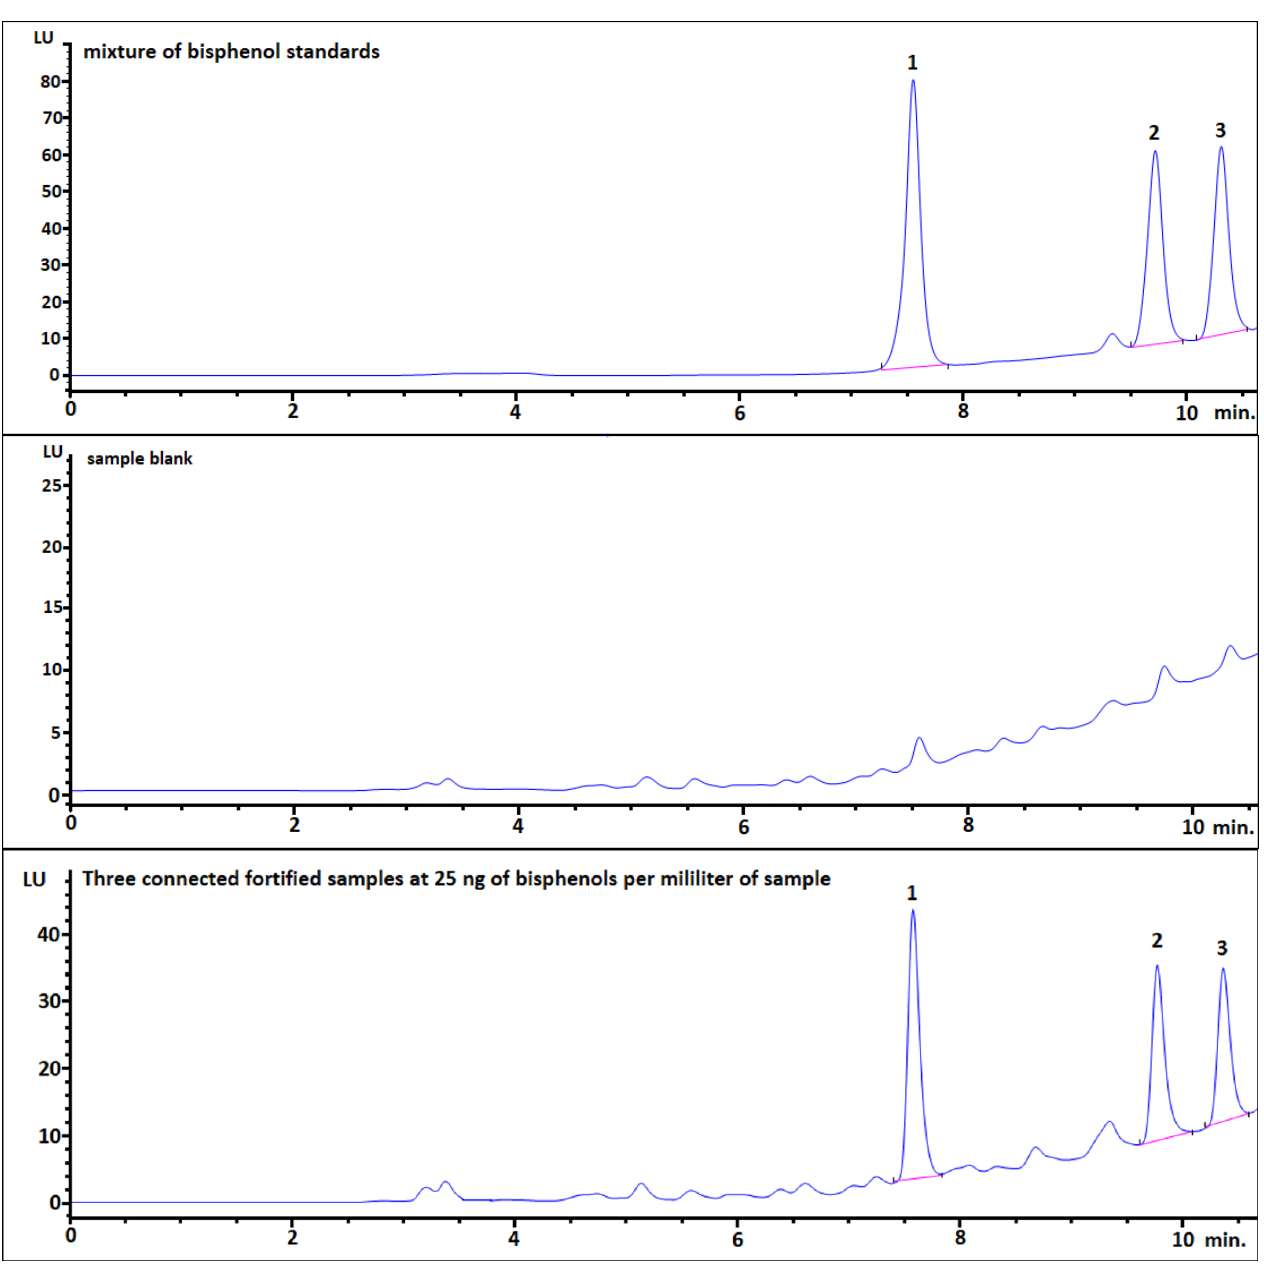
Figure 2. Comparison of following chromatograms: mixture of bisphenol standards ( top ); chromatogram of blank human urine matrix sample ( middle ); three samples of blank human urine matrix samples which were spiked with mixture of bisphenol standards at the same level (25 ng/mL), after the SPE procedure, then were evaporated to dryness, connected, and reconstituted as one sample for analysis ( bottom ).